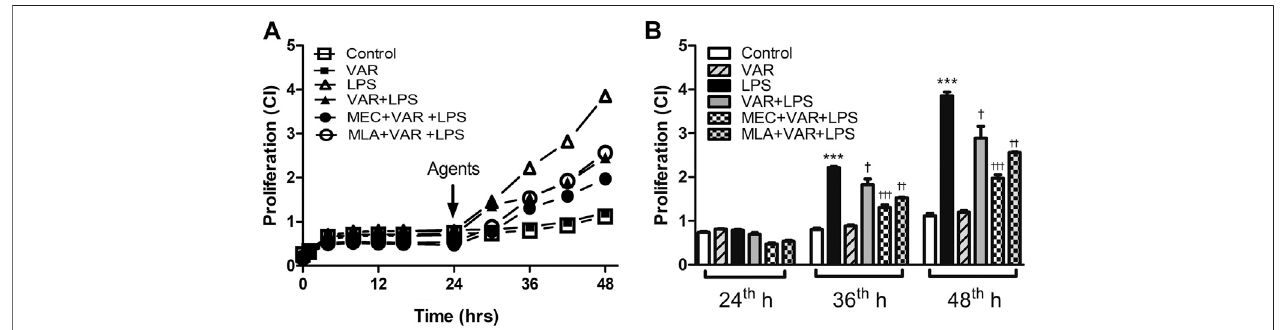
FIGURE 5 | Effects of varenicline on LPS-induced cell proliferation in the presence or absence of nAChR antagonists. Shown are line graphs drawn from the averaged data points of the real-time proliferation assay tracings (A) and the cumulative data (B) . RAW 264.7 cells were treated with varenicline (VAR, 1 μ M) in the presence or absence of mecamylamine (MEC, 50 μ M) and methyllycaconitine (MLA, 1 μ M) prior to lipopolysaccharide (LPS, 4 μ g/ml) administration at 24th hour. Then, cell proliferation rates were monitored for 24 h after the treatments. Data are expressed as mean ± S.E.M. (*** p < 0.01 vs. the control group † p < 0.05; †† p < 0.01, ††† p < 0.001 vs. the LPS group, n (cid:1) 5 – 7, One-way ANOVA with post hoc Tukey – Kramer multiple comparisons test or Student ’ s t -test). CI: cell index.